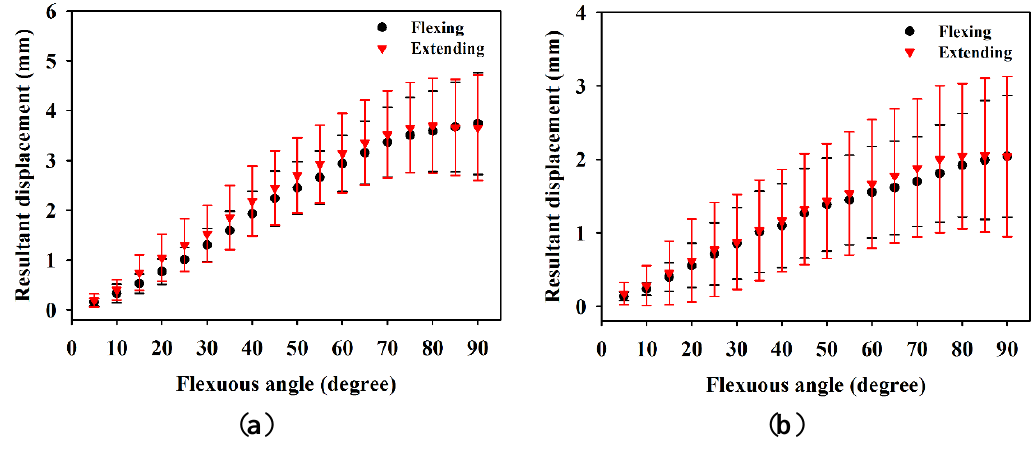
Figure 7. Resultant displacements of the MN while flexing and extending fingers in ( a ) males and ( b ) females.